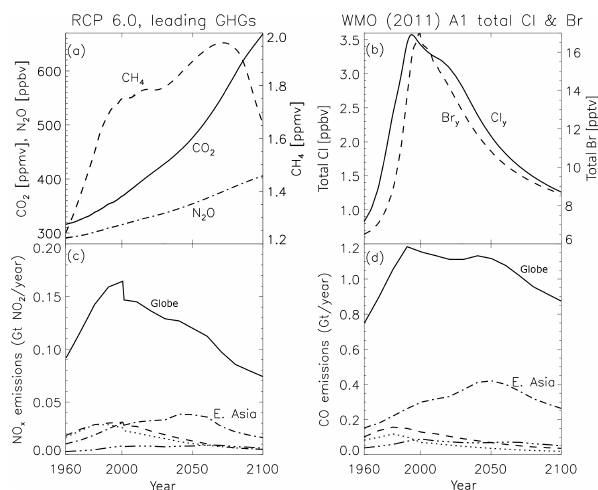
Figure 1. Selected forcings used in the REF-C2 simulations. (a) Carbon dioxide (CO 2 ; solid), methane (CH 4 ; dashed), and ni- trous oxide (N 2 O; dash-dotted) surface mass-mixing ratios, follow- ing RCP 6.0 (Meinshausen et al., 2011). (b) Total chlorine (Cl; solid) and total bromine (Br) excluding the mass-mixing ratios of the VSLSs (dashed; scenario A1 of WMO, 2011). (c) Total nitro- gen oxide (NO x ) emissions. Solid: global; dashed: Europe; dotted: North America; dash-dotted: East Asia; dash-dot-dot-dotted: South Asia. (d) Same but for carbon monoxide